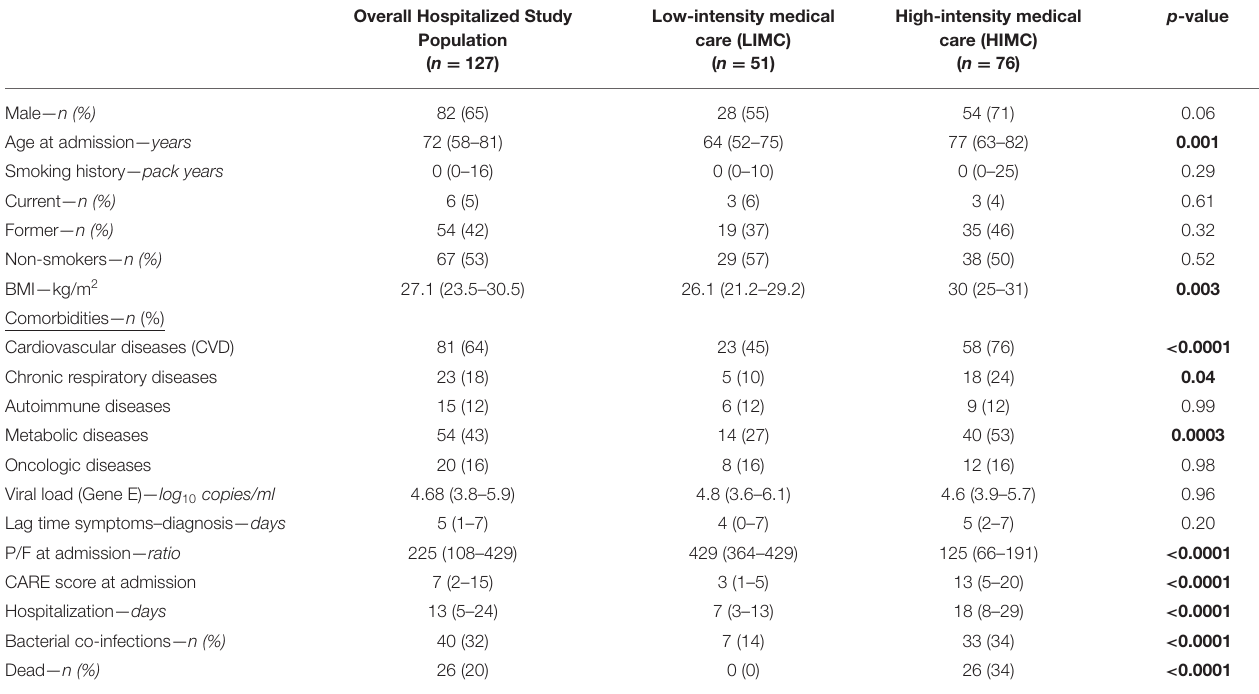
TABLE 2 | Baseline demographics and clinical features of the overall hospitalized study population for SARS-CoV-2 related infection, and of the two subgroups categorized in low (LIMC) and high (HIMC) intensity medical care. Overall Hospitalized Study